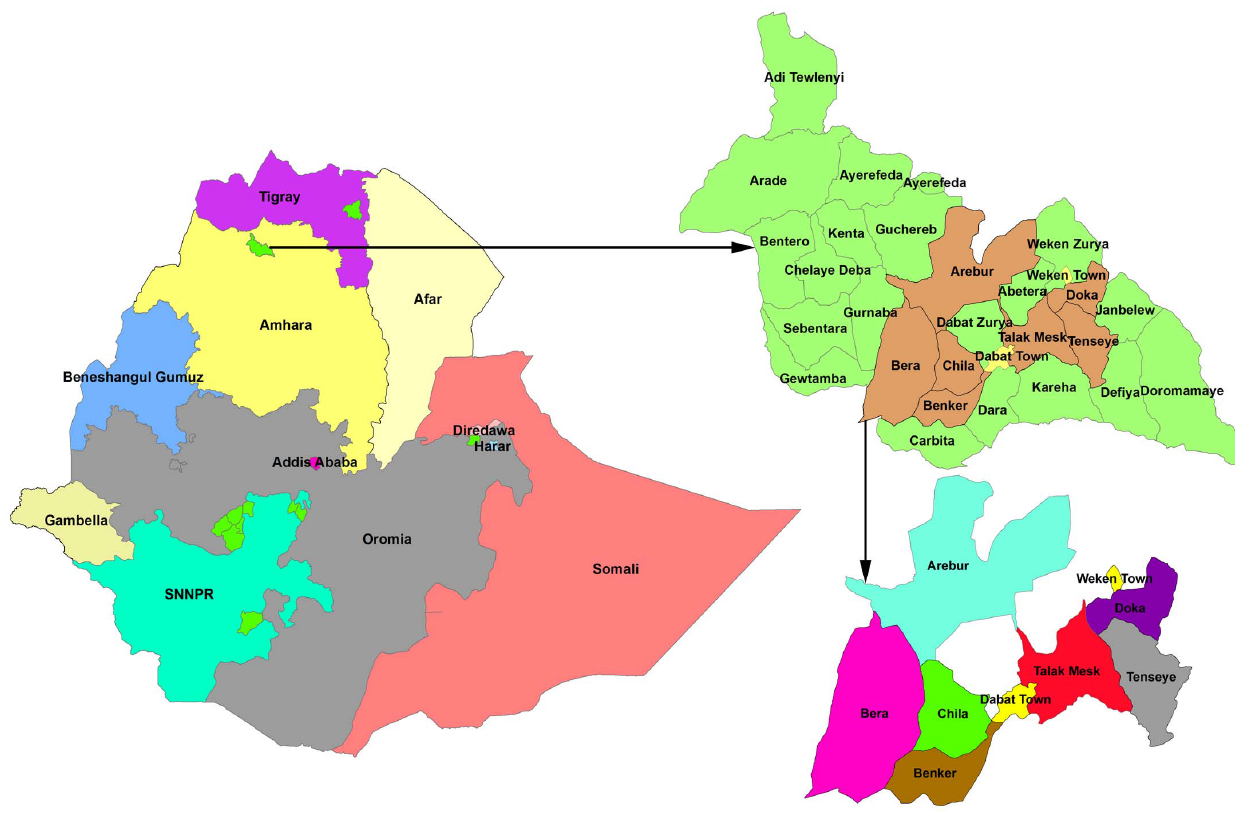
Figure 1. Map of Ethiopia, Dabat District and Dabat HDSSs [Ref.13].